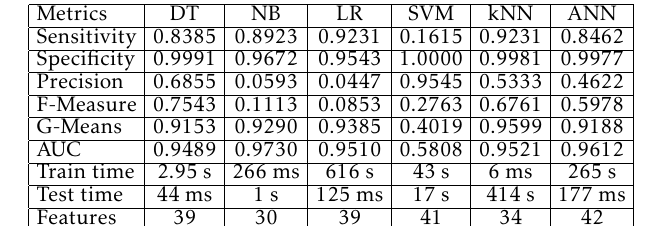
Table 4. Results of using GR-BFE algorithm on WORMS. Metrics